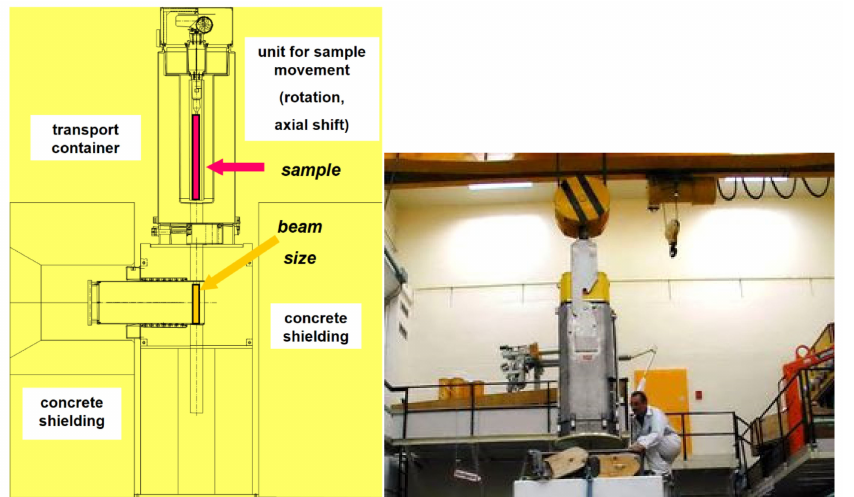
Figure 1. Principal set-up of NEURAP with access for the dedicated cask via the roof of the NEUTRA bunker ( left ), actual handling with the loaded transport container in PSI’s hotlab ( right ) [3], copyright permission by Elsevier, 2003.